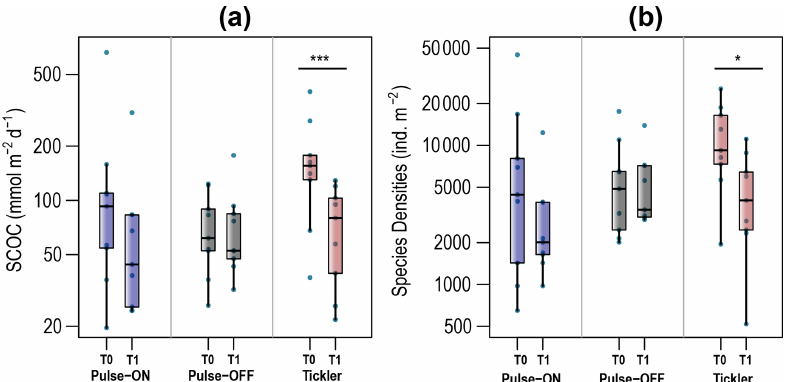
Figure 5. Oxygen consumption (a) and macrobenthos densities (b) measured from treatment plots before ( T 0) and after ( T 1) fishing. The y axes are on a log